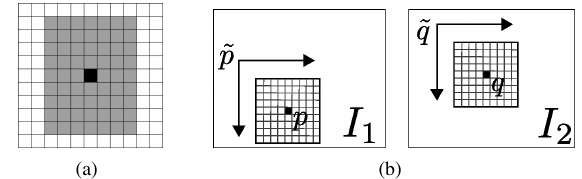
Figure 3: a) The 7 × 9 window D of the Census transform, b) The basic scheme for the adaptive